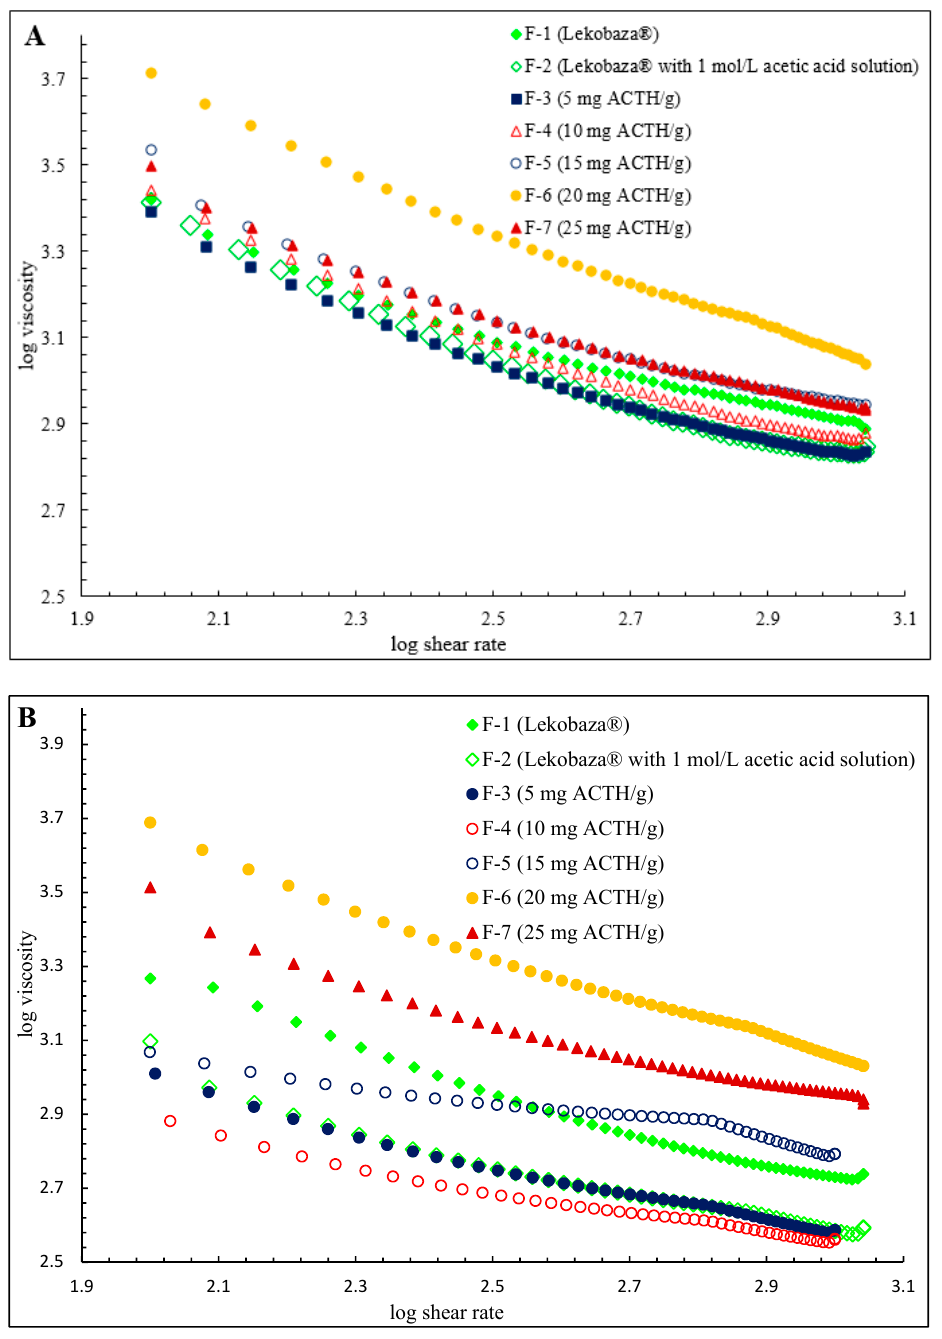
Figure 2. The course of viscosity curves in the controlled shear stress mode as a logarithmic function at 25 ( A ) and 32 °C ( B ).